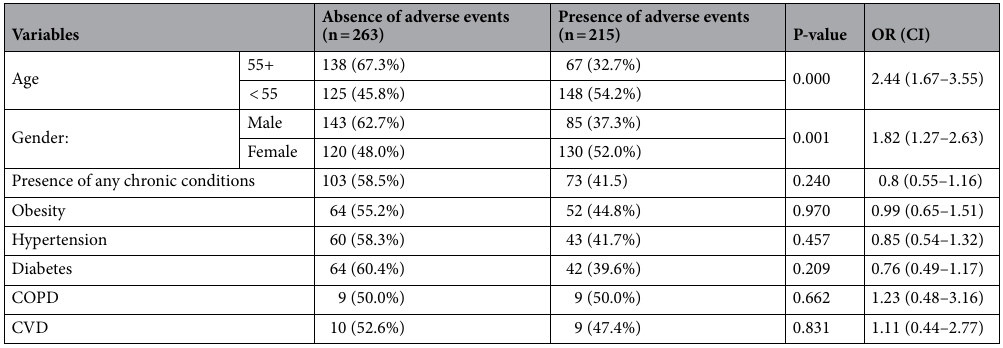
Table 6. Risk factors associated with the development of adverse events following AstraZeneca vaccine.